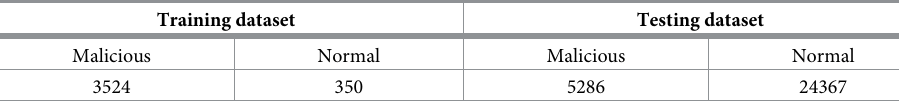
Table 4. Test and training dataset—Malware and APT dataset.